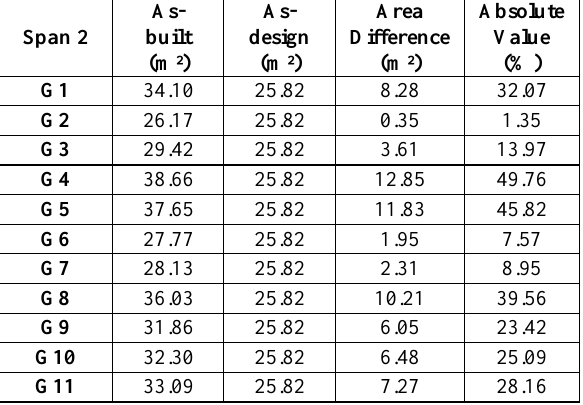
Table 4. Results for eleven girders in Span